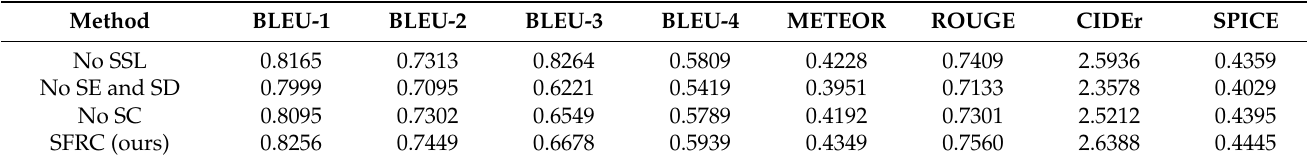
Table 11. Comparison of evaluation metric scores of methods for removing different components on Sydney-Captions